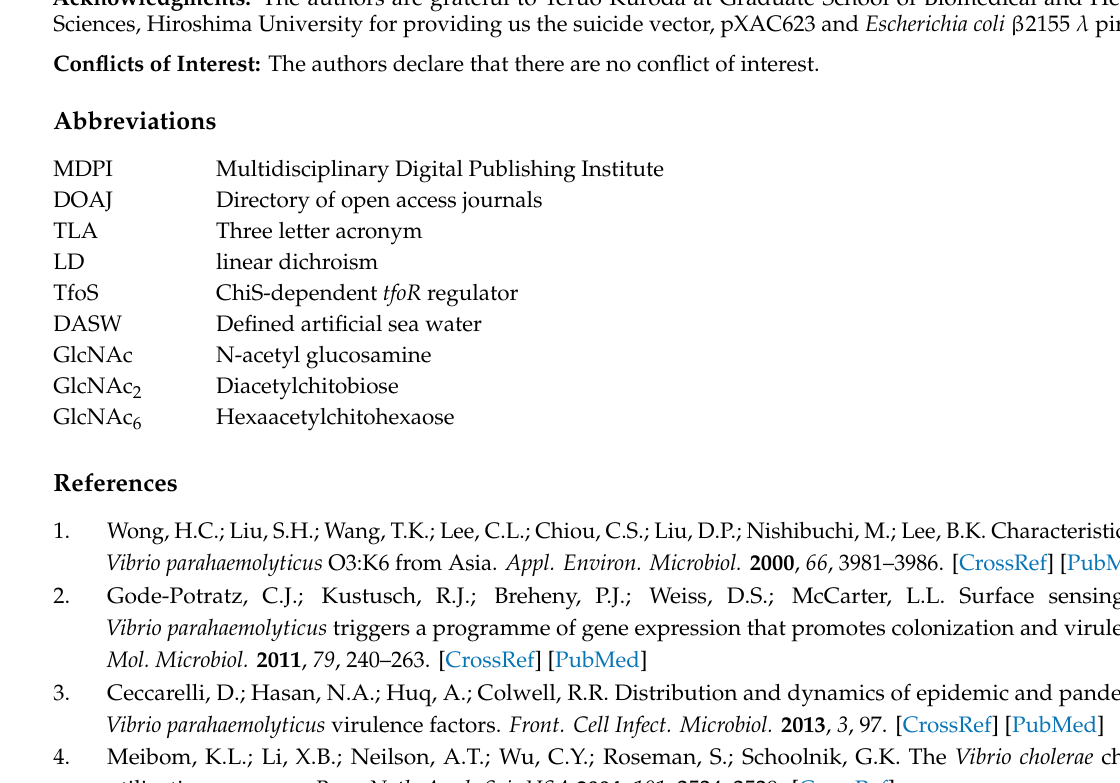
Figure S1: The relative expression of competence genes tfoX , pilA , comEA and qstR at mRNA level was checked for WT, ∆ chiS and ∆ tfoS mutant in the presence of chitin; Figure S2: The relative mRNA expression of competence genes tfoX , pilA , comEA and qstR was compared in the presence of GlcNAc 2 and GlcNAc 6 in wild type